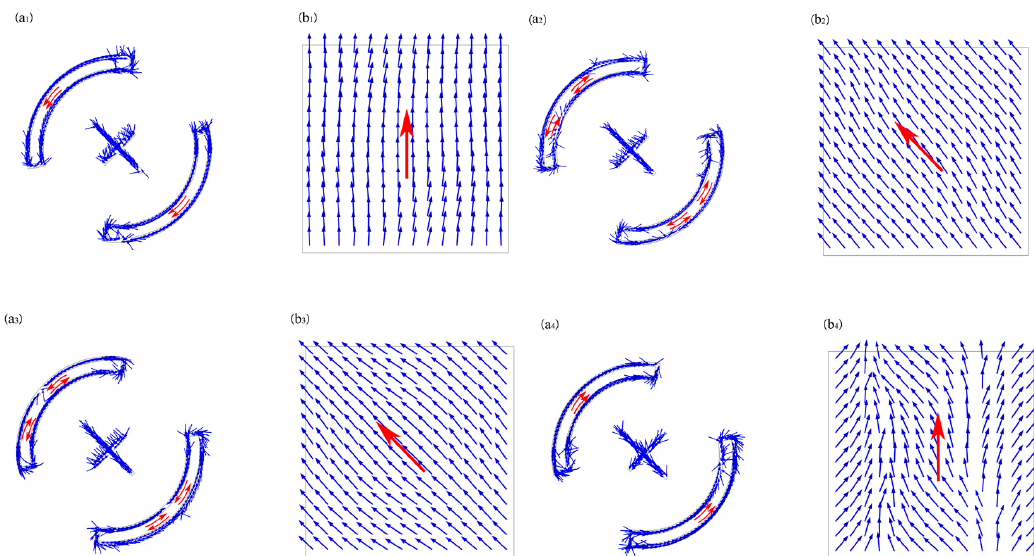
Figure 4. Distributions of the surface currents on the top (( a 1 )–( a 4 )) and bottom (( b 1 )–( b 4 )) layers of the presented metasurface for the resonance frequencies of 10.67 GHz, 12.22 GHz, 16.18 GHz and 19.51 GHz, respectively.